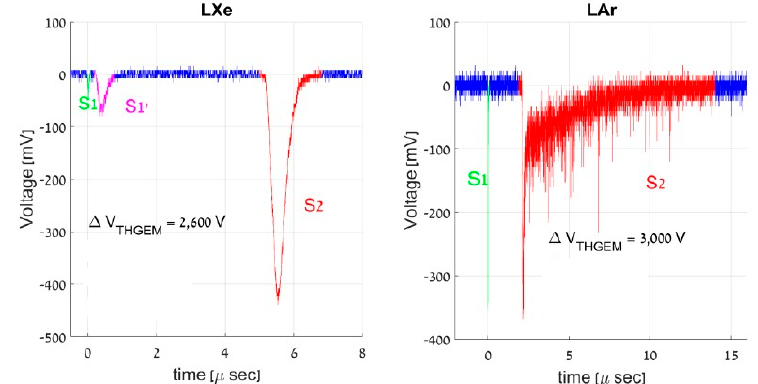
Figure 31. Example of EL signals (S2 signals) induced by alpha particles, recorded from a LHM detector [59]: ( left ) in liquid Xe and bare-PMT and ( right ) in liquid Ar and TPB-coated PMT.